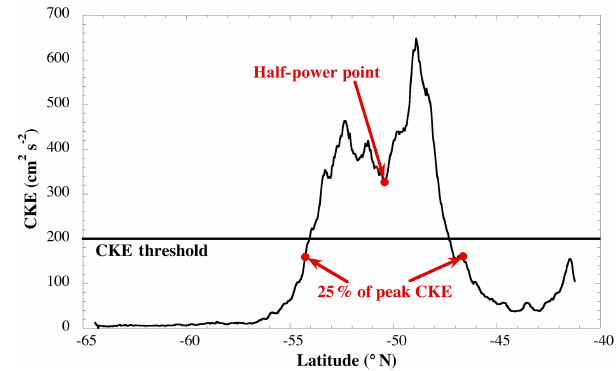
Figure 3. An example profile of mean CKE (1993–2016) along a ground track in the southern Indian Ocean (shown in orange in Fig. 2), demonstrating the location of the half-power point and the locations of the southern and northern boundaries of the enhanced CKE envelope. See text for details of the